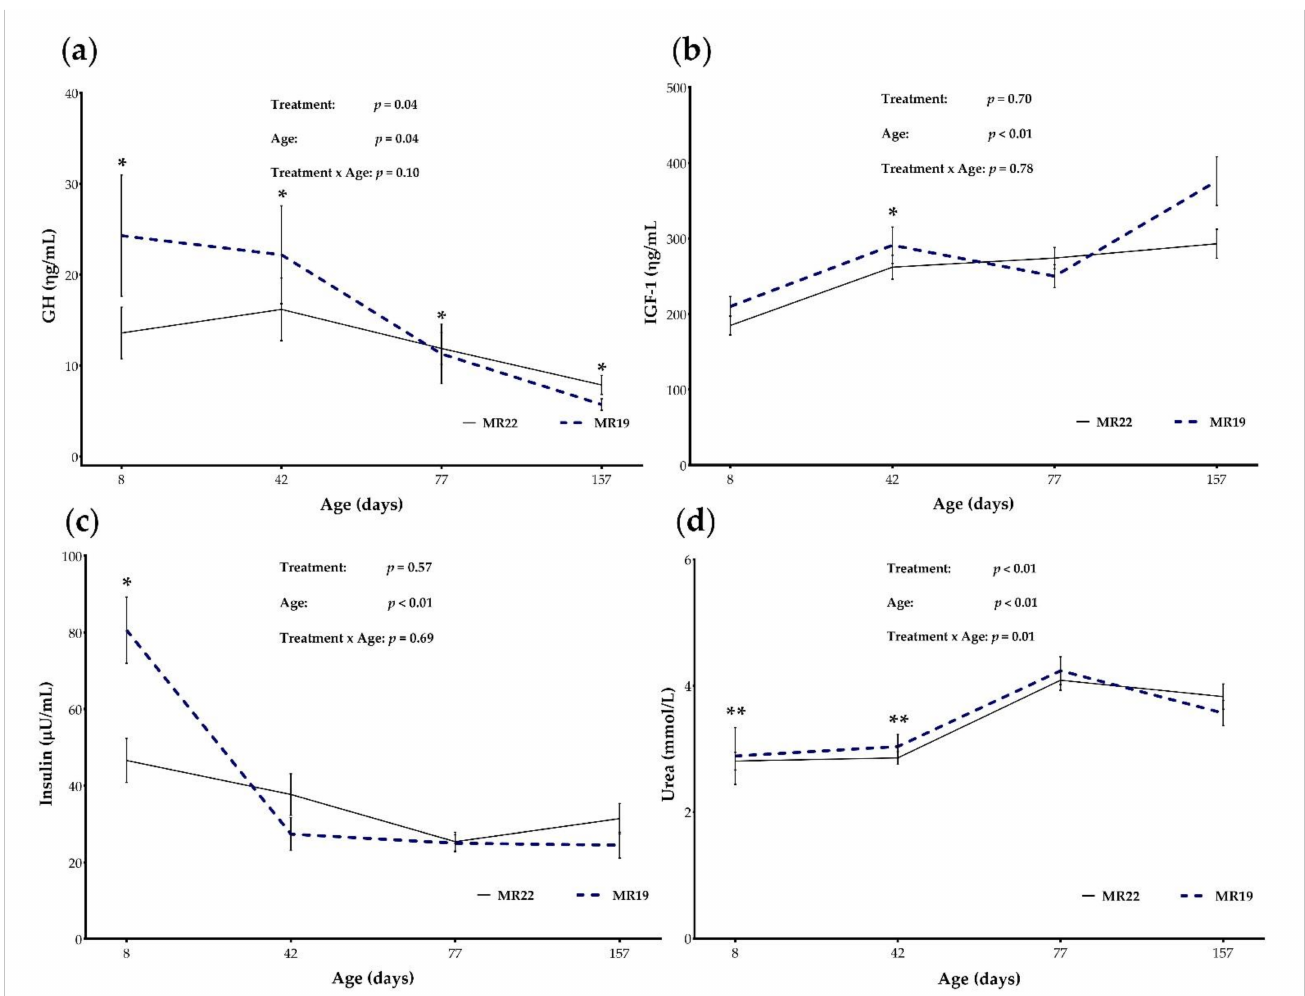
Figure 4. Blood metabolites represented as means and standard error bars of ( a ) GH, ( b ) IGF-1, ( c ) Insulin, and ( d ) Urea concentration of calves fed with milk replacer content 22% CP (MR22; n = 35) or 19% CP (MR19; n = 33), according to time periods. * Denotes difference with p < 0.05 or ** p <